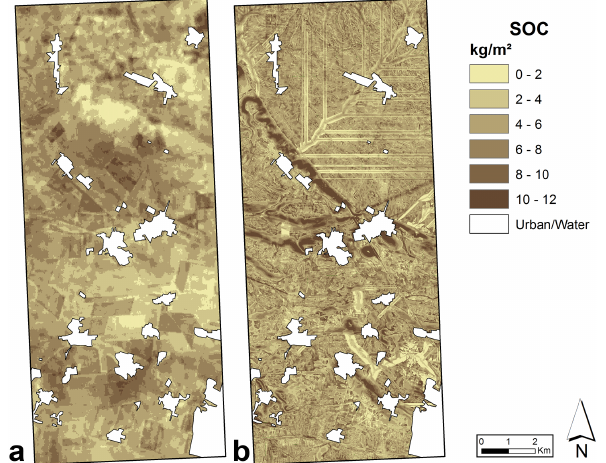
Figure 3. Subsoil SOC stock modelled by (a) the direct approach and (b) the indirect approach. Overlaid on a hillshade to show rela- tionship with relief and field boundaries.